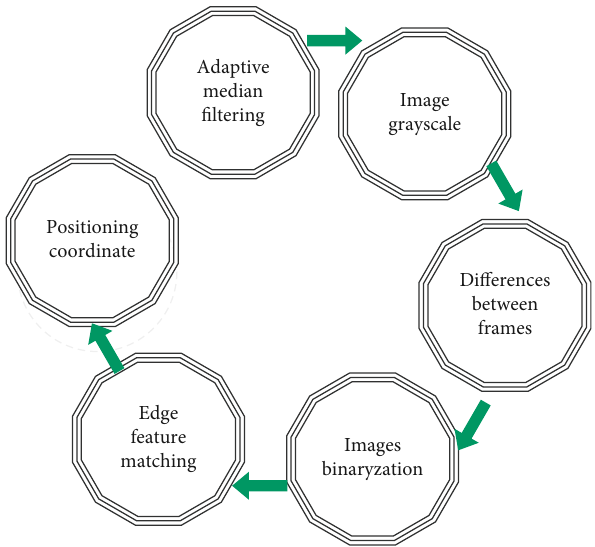
Figure 1: Steps of edge feature matching